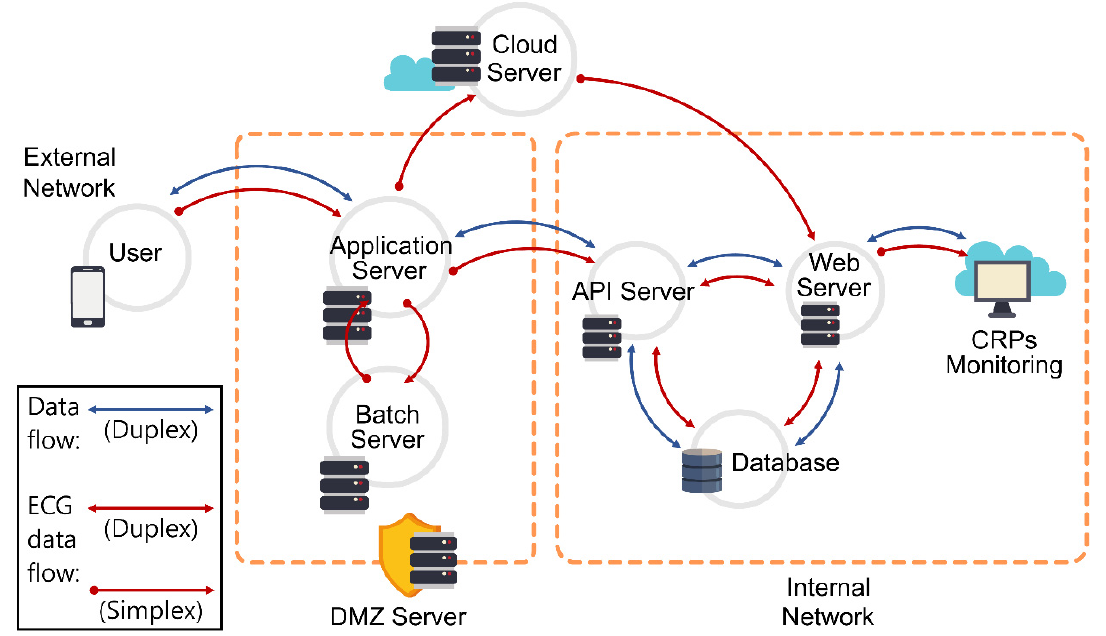
Figure 3. Network server configuration diagram. API (Application Programming Interface) is a soft- ware intermediary that allows two applications to communicate with each other. DMZ (Demilita- rized zone) is a small, isolated network located between an external and internal network for data